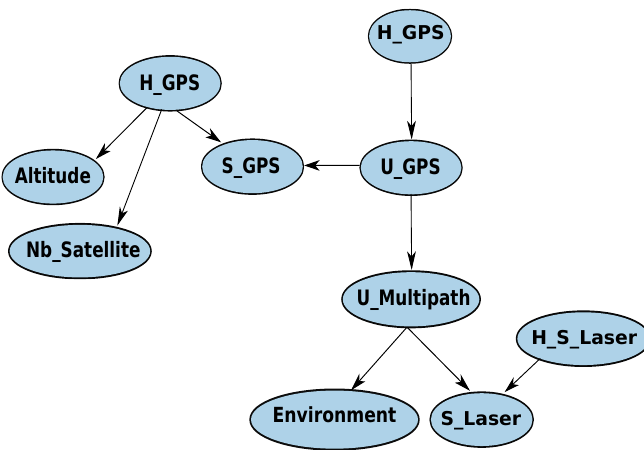
Figure 25. BN GPS used for the parameters learning.